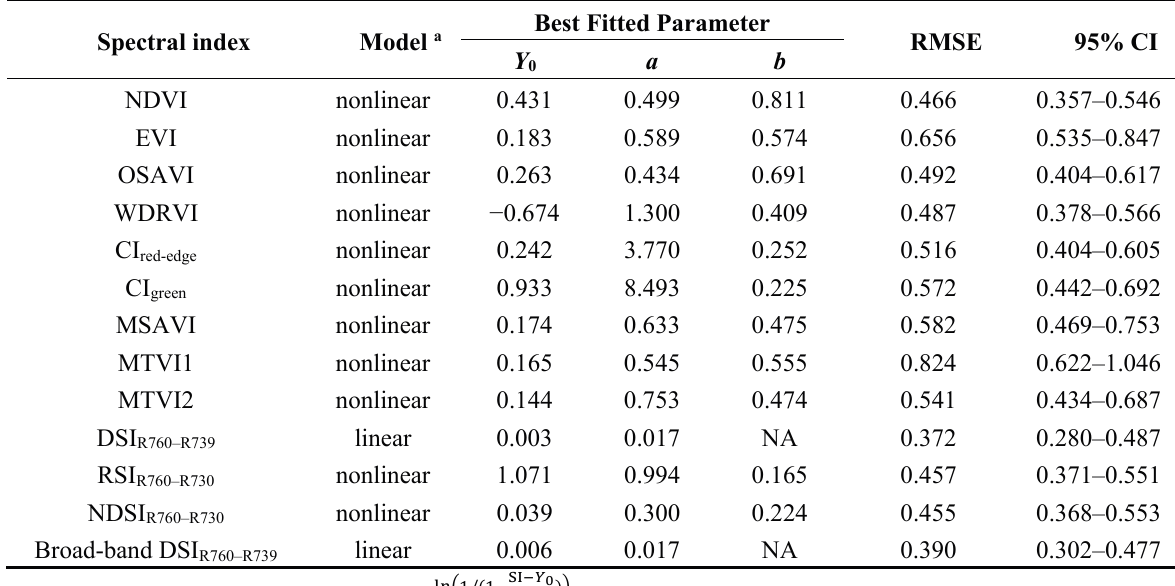
Table 5. Best-fitted parameters, point-estimated mean values of RMSE, and 95% confidence intervals (CIs) of RMSE for narrow-band and broad-band SIs calculated by a modified bootstrap procedure.